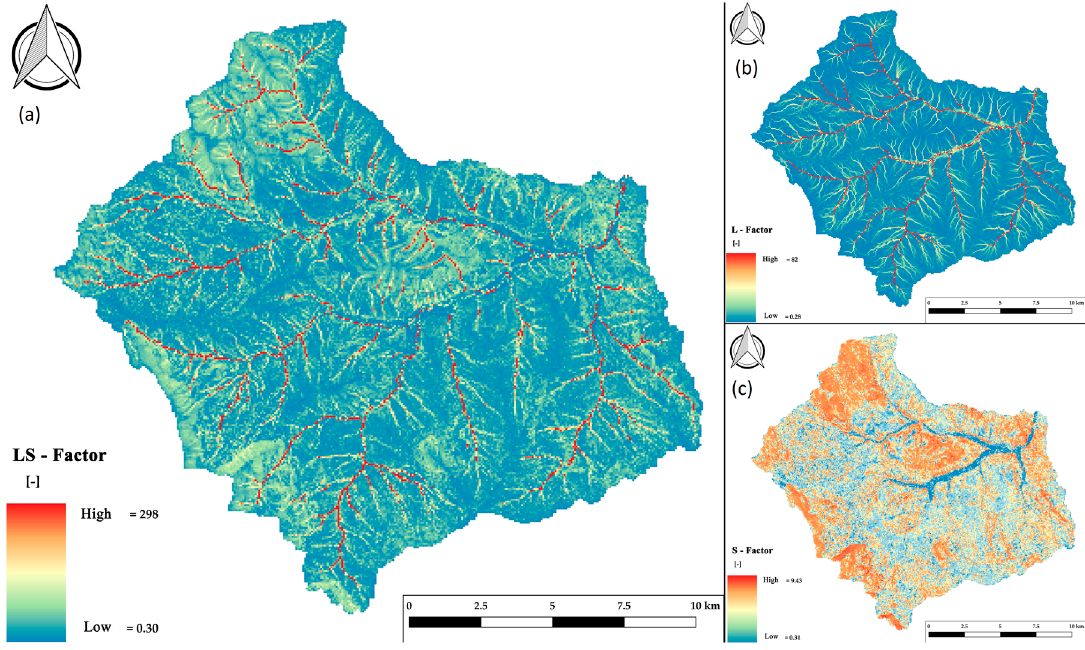
Figure 7. Topographic factor: ( a ) LS-Factor map, ( b ) Length (L)-Factor map, ( c ) Slope (S)-Factor map.